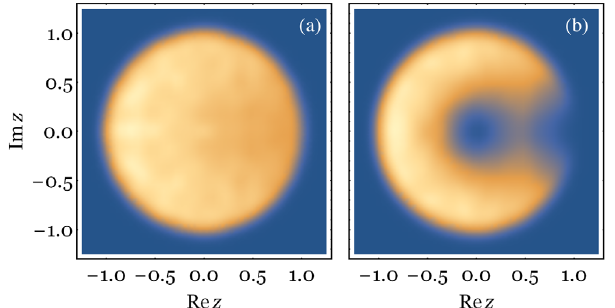
FIG. 11. Complex spacing density for the Markov matrix describing the ASEP, with (a) nonstaggered and (b) staggered hopping probabilities, for N ¼ 16